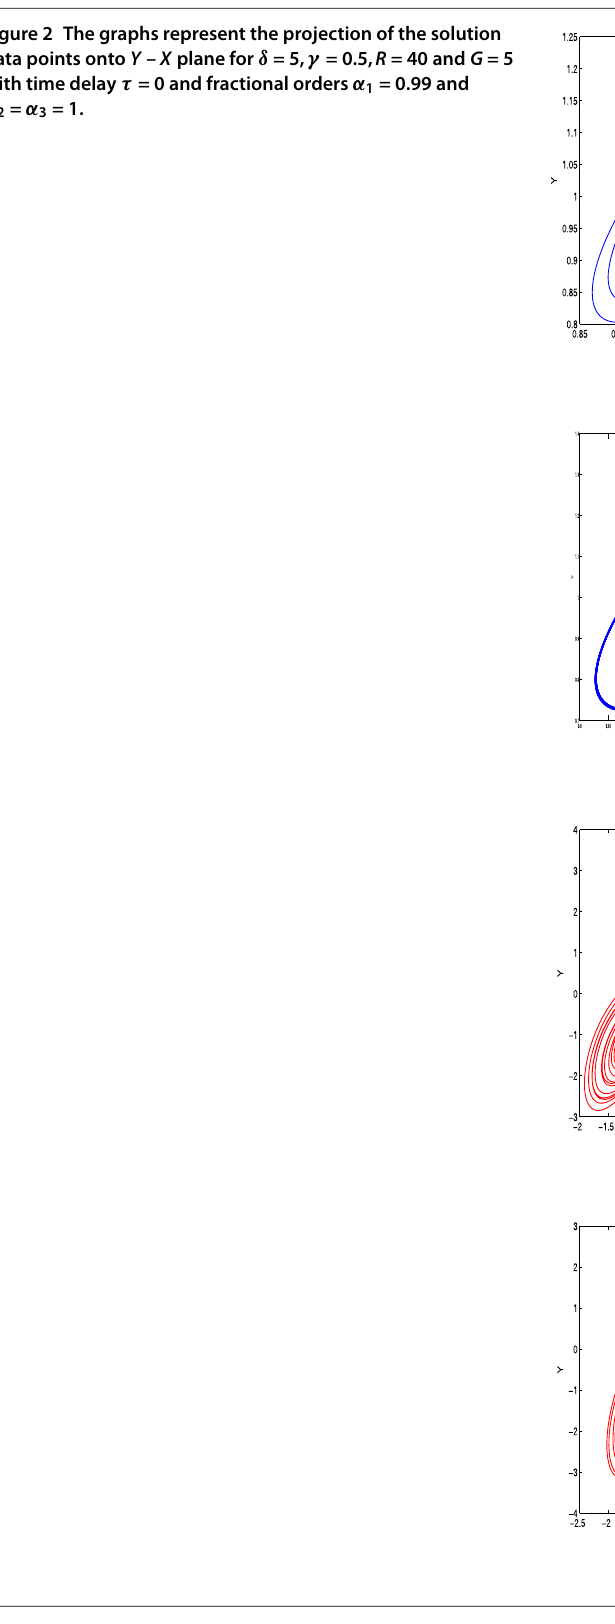
Figure 2 The graphs represent the projection of the solution data points onto Y – X plane for δ = 5, γ = 0.5, R = 40 and G = 5 with time delay τ = 0 and fractional orders α 1 = 0.99 and α 2 = α 3 =